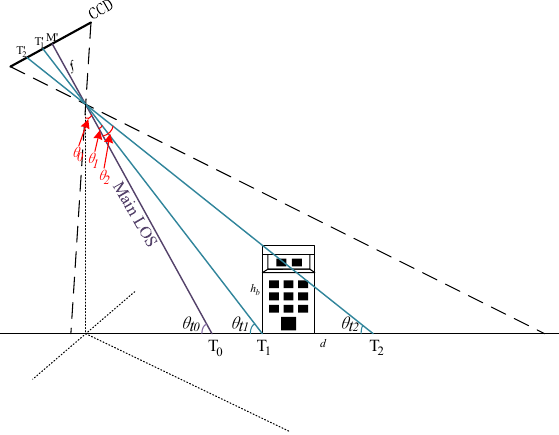
Figure 9. Geometric relationship of the area array camera building imaging.